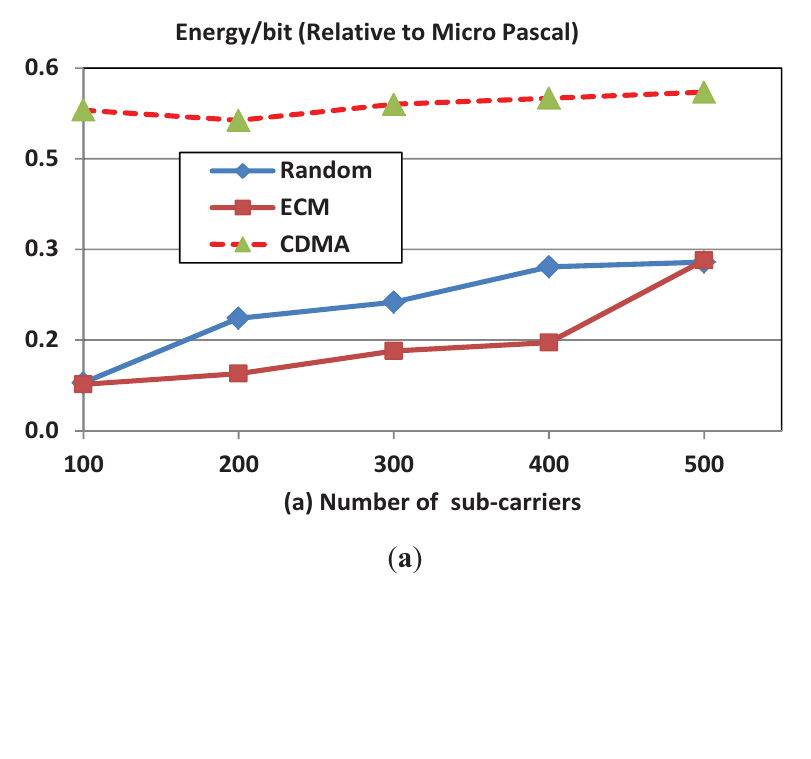
Figure 6. ( a ) Energy per transmitted bit; ( b ) Throughput for OFDMA and CDMA